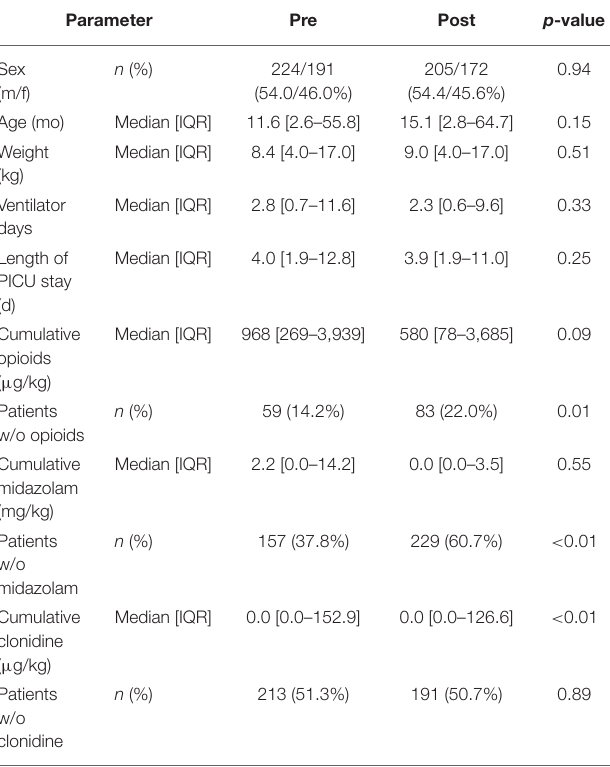
TABLE 2 | Prevalence of delirium and withdrawal symptoms in all patients, in patients grouped by age, and in patients grouped by disease. Parameter Pre Post p -value All